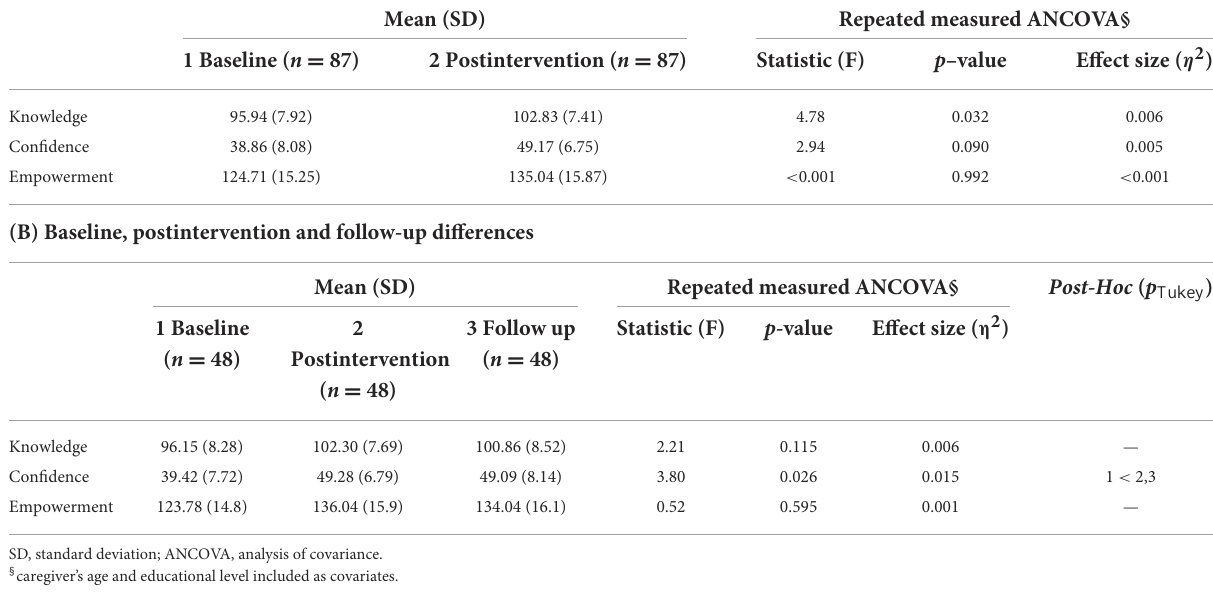
TABLE 5 Child outcomes-baseline, postintervention and follow-up